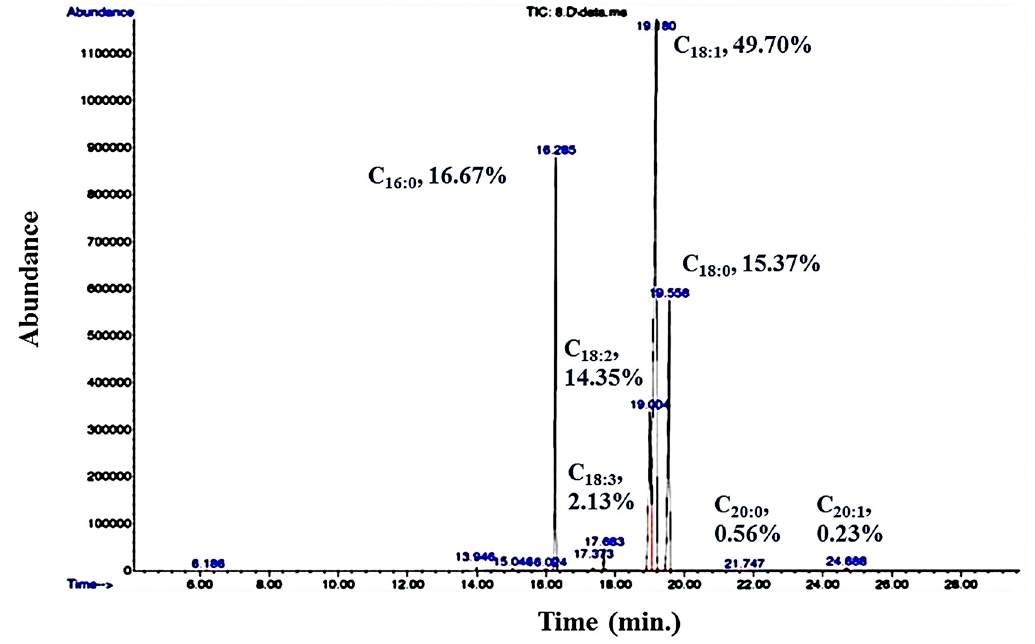
Figure 6. GC-MS chromatogram showing the fatty acid profile of R. kratochvilovae cultivated in CBM.